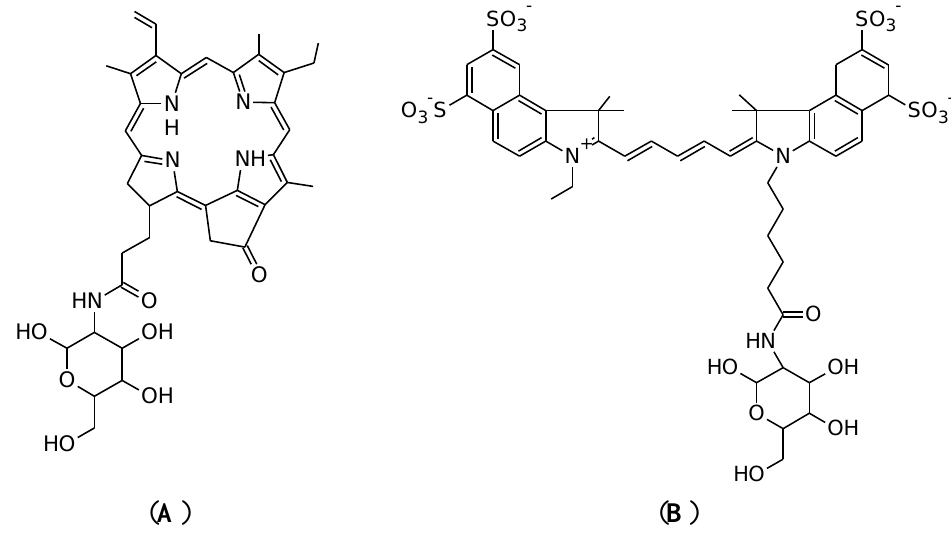
Figure 4. ( A ) Chemical structure of pyropheophorbide 2-deoxyglucosamide (Pyro-2DG), developed in 2003 by Gang Zheng at the University of Pennsylvania; ( B ) Chemical structure of Cy5.5- D -glucosamine (Cy5.5-2DG), developed in 2006